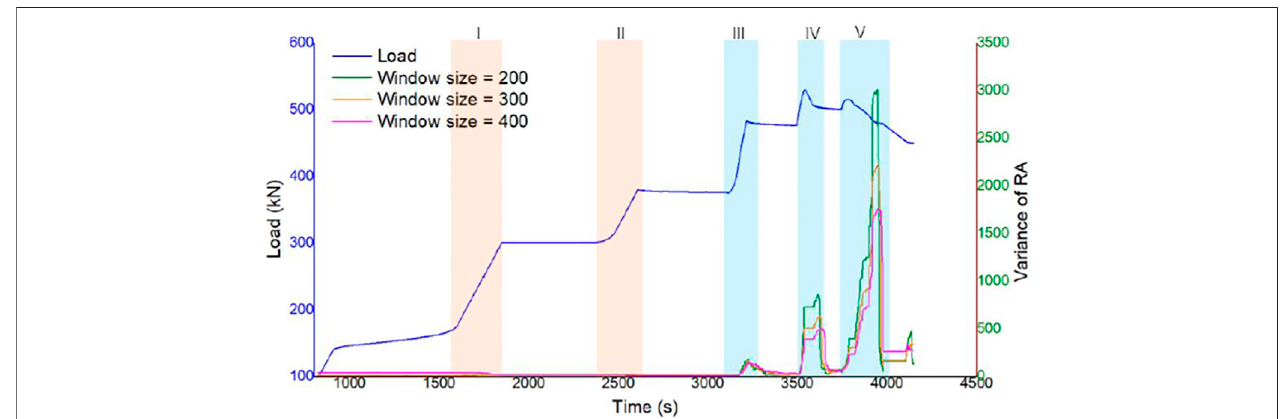
FIGURE 9 | Variance analysis of RA characteristics of rock under multi-phase uniaxial compression.